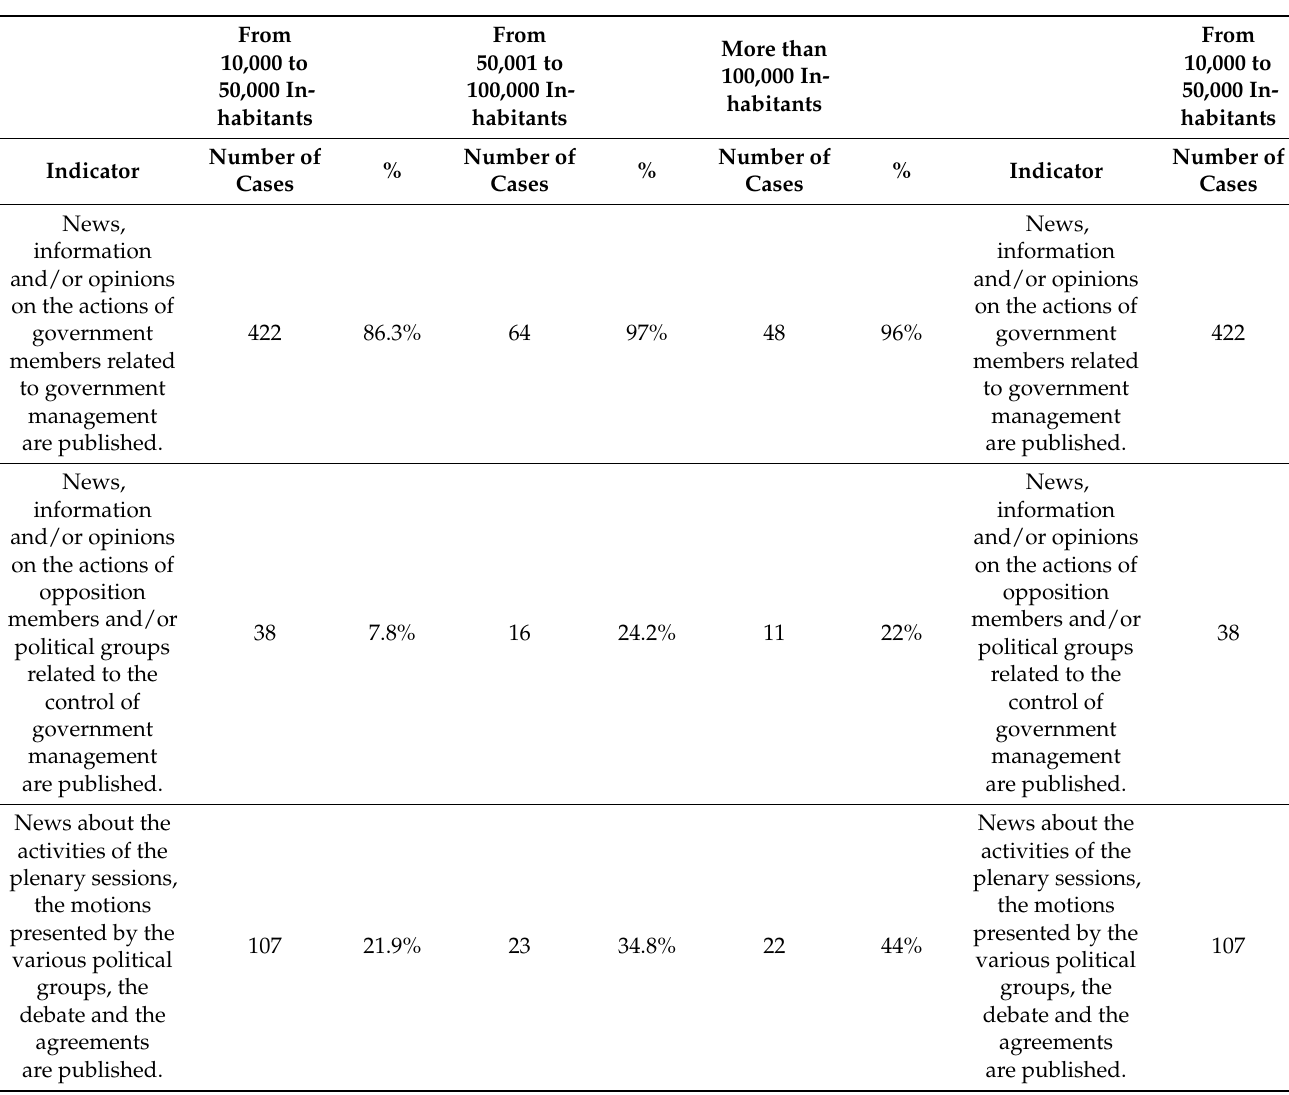
Table 1. Information for